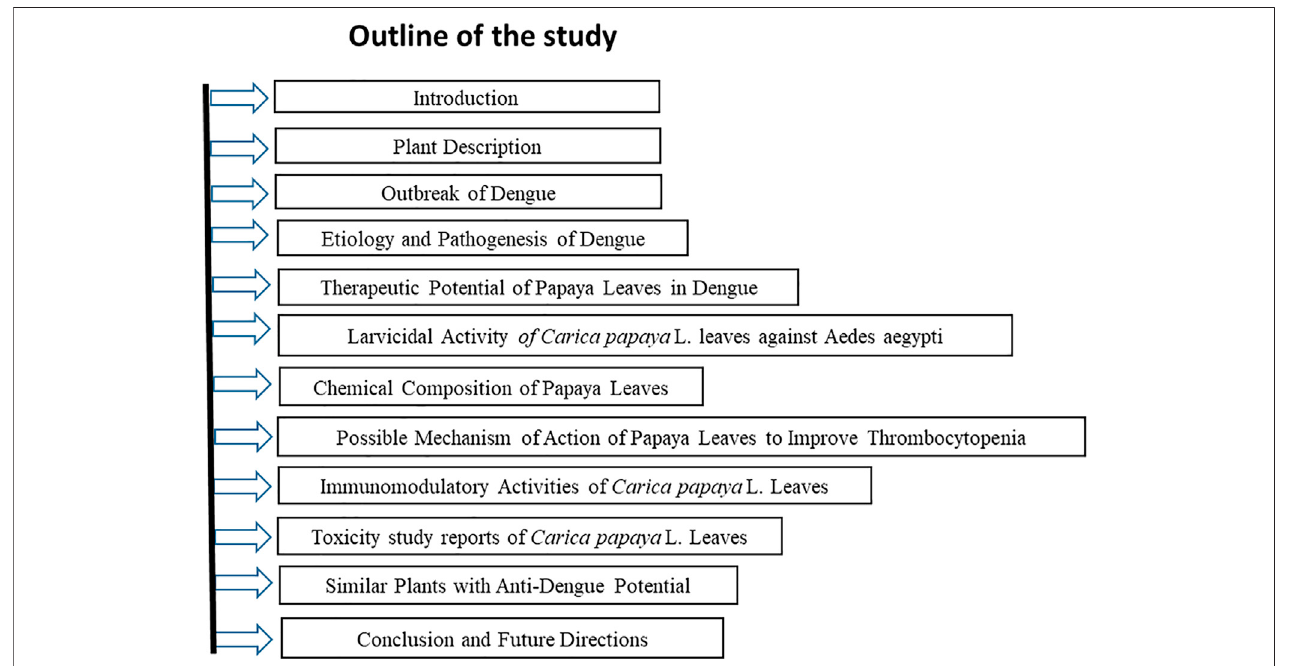
FIGURE 1 | Outline of the Study: Therapeutic Potential of Carica papaya L. Leaves against dengue fever.